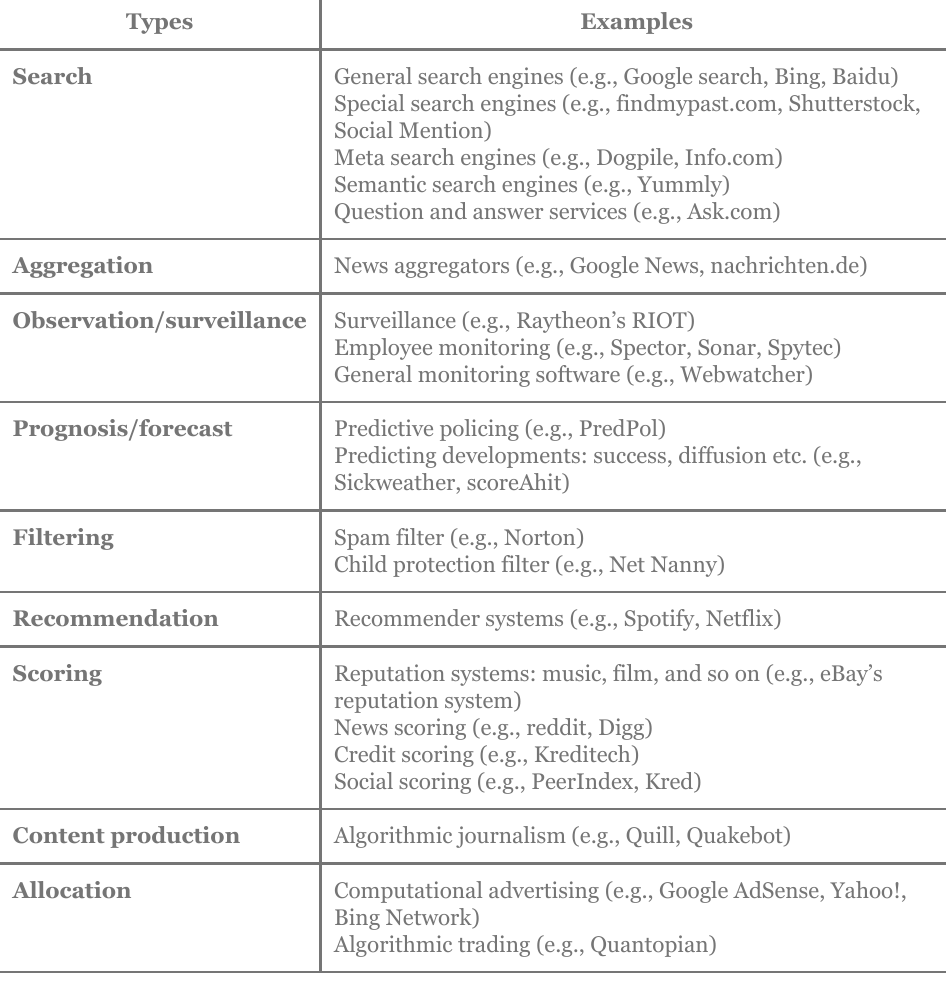
Table 1: Functional typology of AS applications (adapted from Latzer et al., 2016)